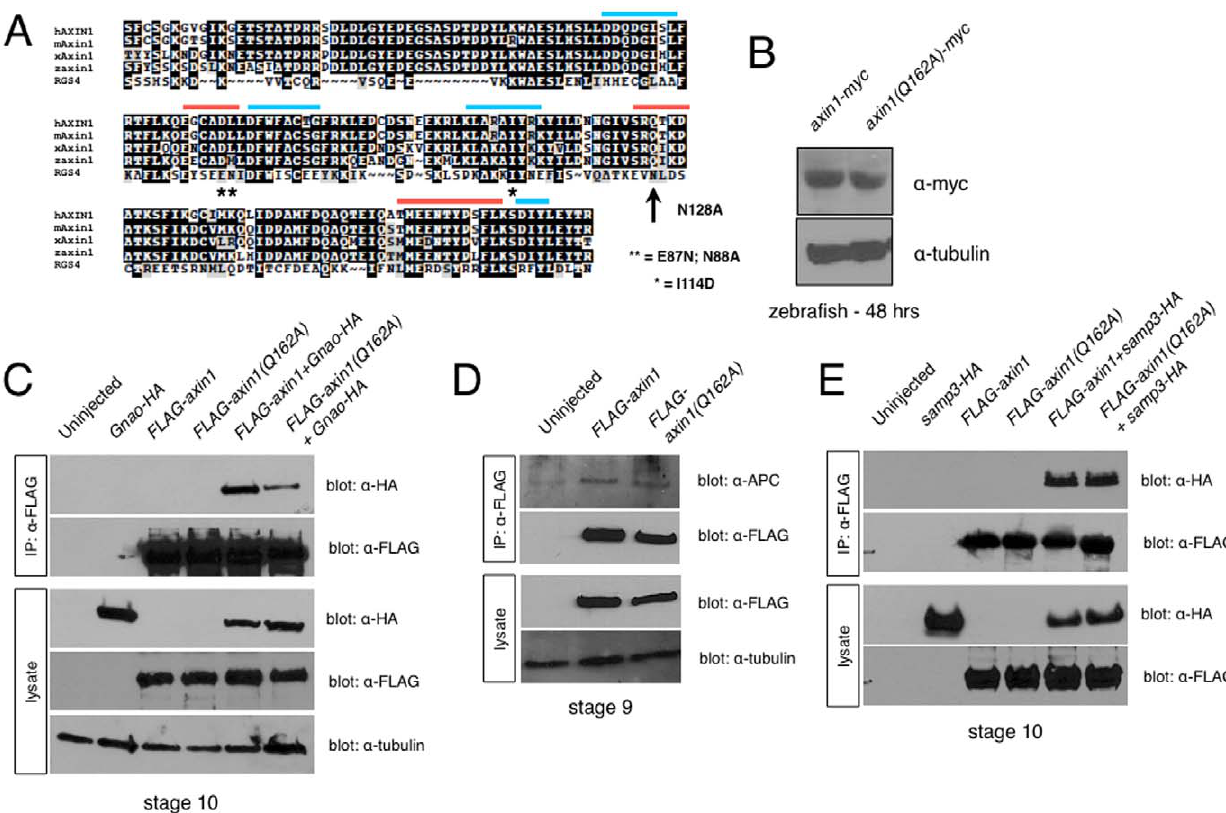
Figure 1. Structure-function analysis of the Axin1 RGS domain. ( A ) Alignment of RGS domains from human (hAXIN1), mouse (mAxin1), Xenopus (xAxin1) and zebrafish Axin1 (zAxin1) with human RGS4. Blue bars=APC binding interface; orange bars=Gna binding interface. *=residues required for GAP activity in RGS4. Arrow=residue required for RGS4 GAP activity, mutated in this study. ( B ) Immunoblots showing equivalent protein expression in 24 hpf zebrafish embryos injected with axin1-myc and axin1(Q162A)-myc . ( C ) Immunoprecipitation of FLAG-tagged Axin1 constructs with HA-tagged Gnao, showing reduced binding of FLAG-Axin1(Q162A) to overexpressed Gnao. ( D ) FLAG-Axin1 and FLAG-Axin1(Q162A) immunoprecipitate endogenous APC equivalently. ( E ) FLAG-Axin1 and FLAG-Axin1(Q162A) immunoprecipitate HA-tagged APC-SAMP3 equivalently.